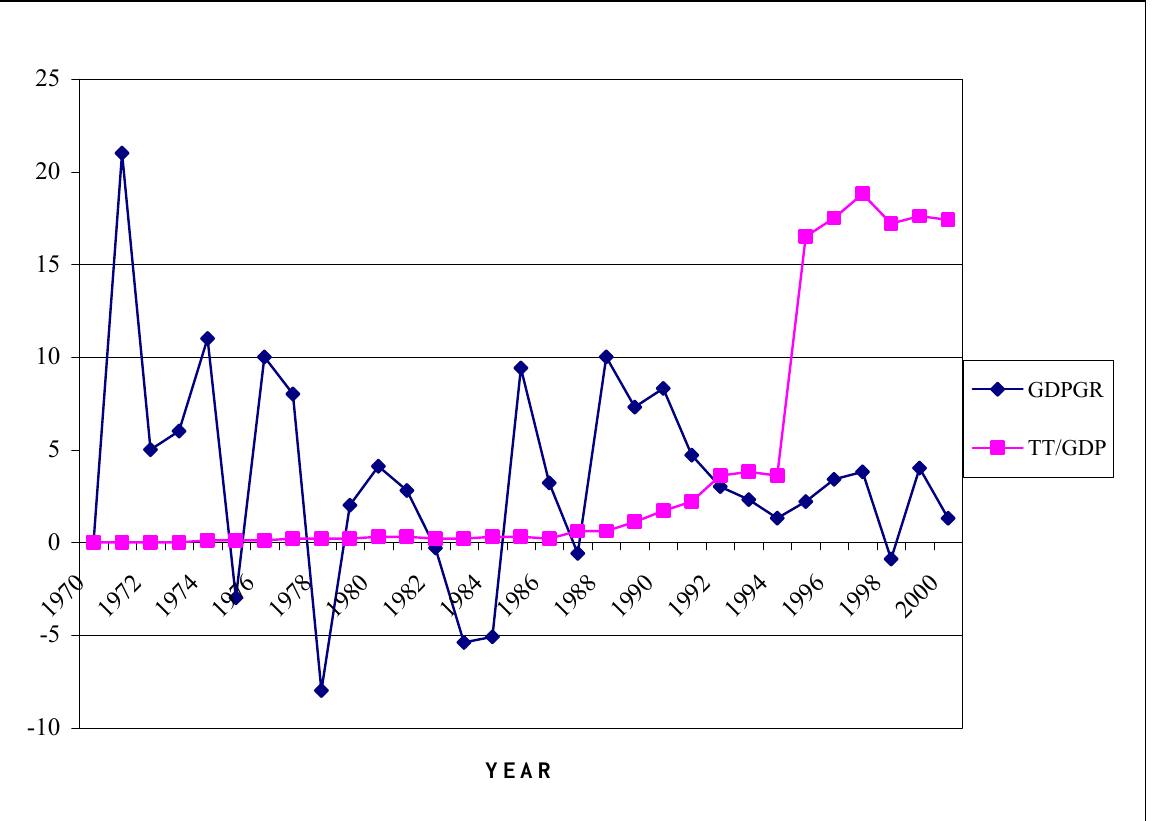
Figure 1 Aggregate output growth and trade openness in Nigeria, 1970-